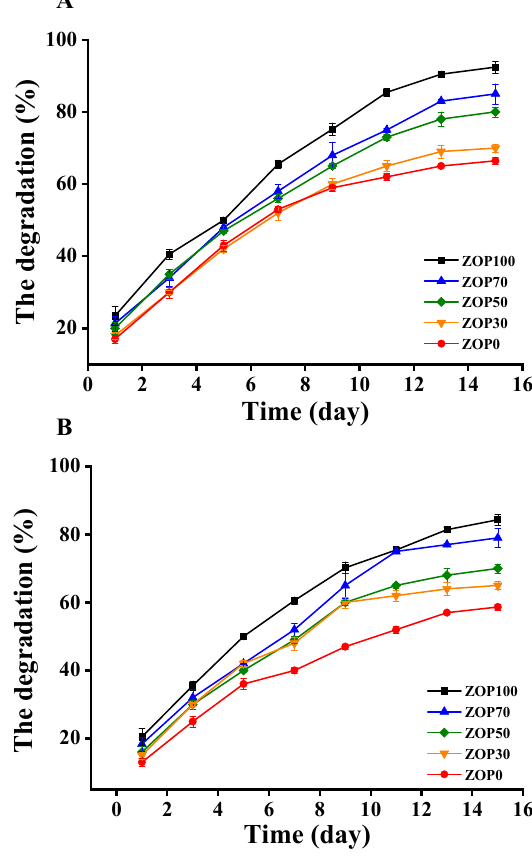
Figure 8. The in vitro degradation profile of different hydrogels in a pH of 1.2 ( A ) and the in vitro degradation profile of different hydrogels in a pH of 7.4 ( B ).